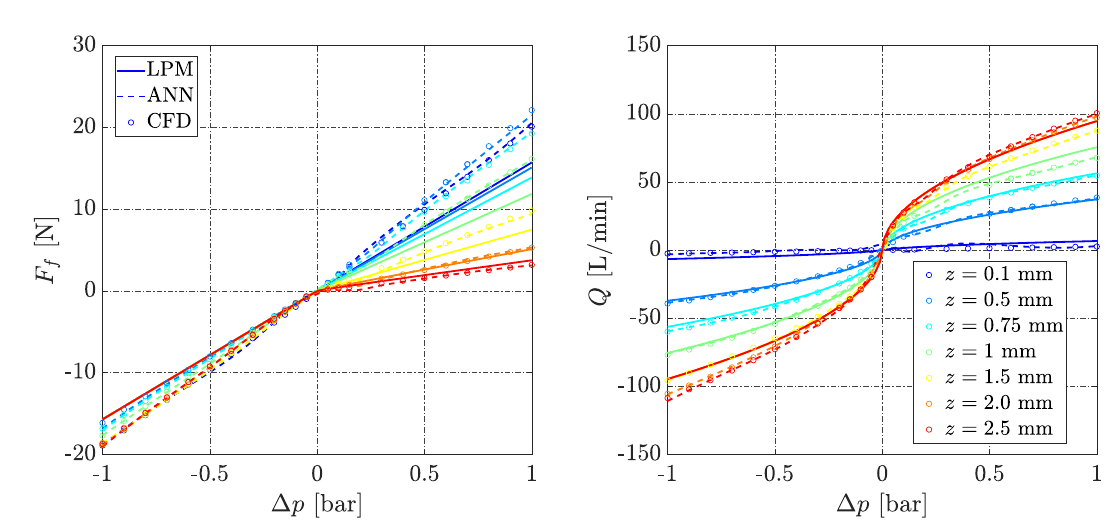
Figure 15: The graphs show static flow force ( F f ) and flow ( Q ) as function of ∆ p = p 2 − p 1 . The results of various methodologies are plotted, and this is repeated for various increments of the plunger position. CFD settings are given in Table 1 and R = 10 mm & w = 2 . 5 mm.